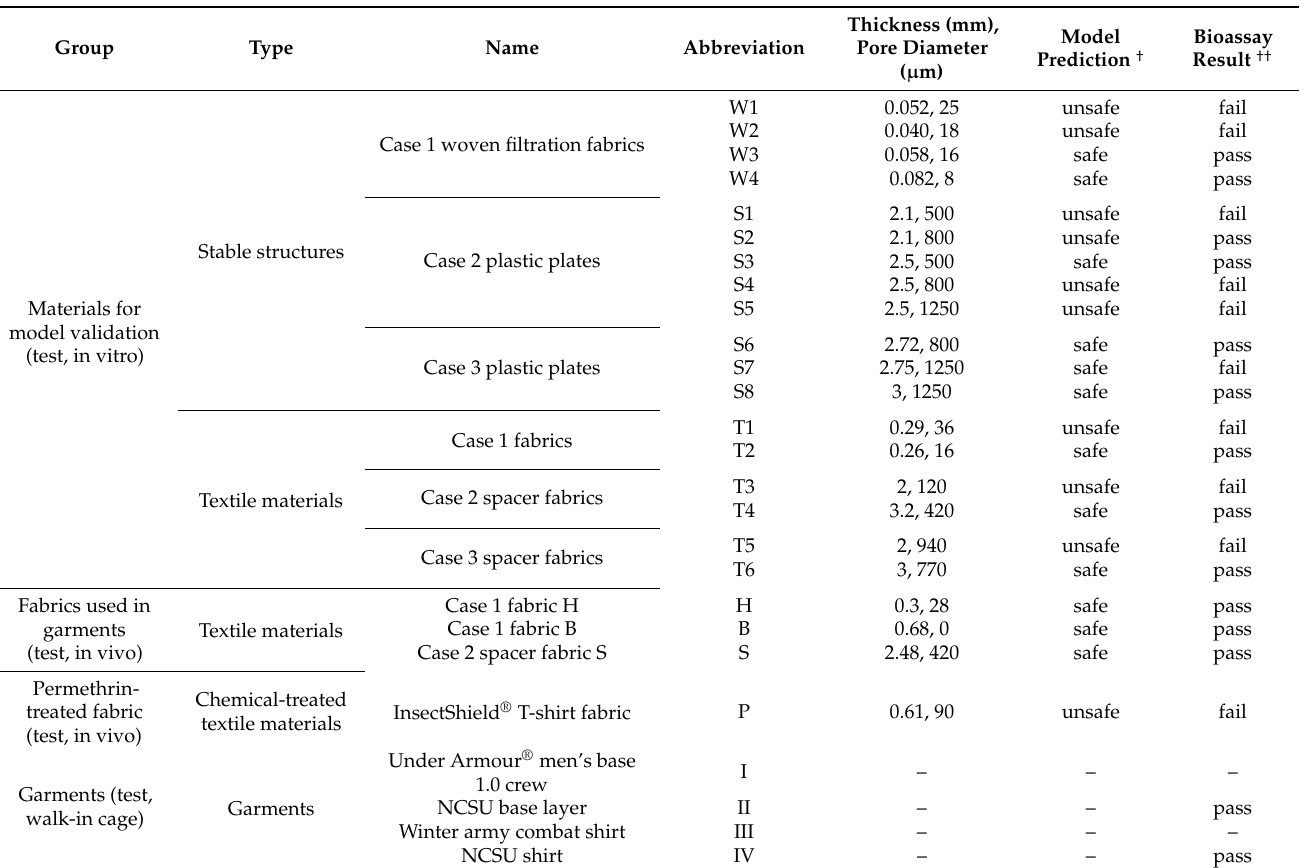
Table 1. Barrier materials studied, their abbreviation, measured thickness and pore diameter, model prediction, and bite-resistance bioassay